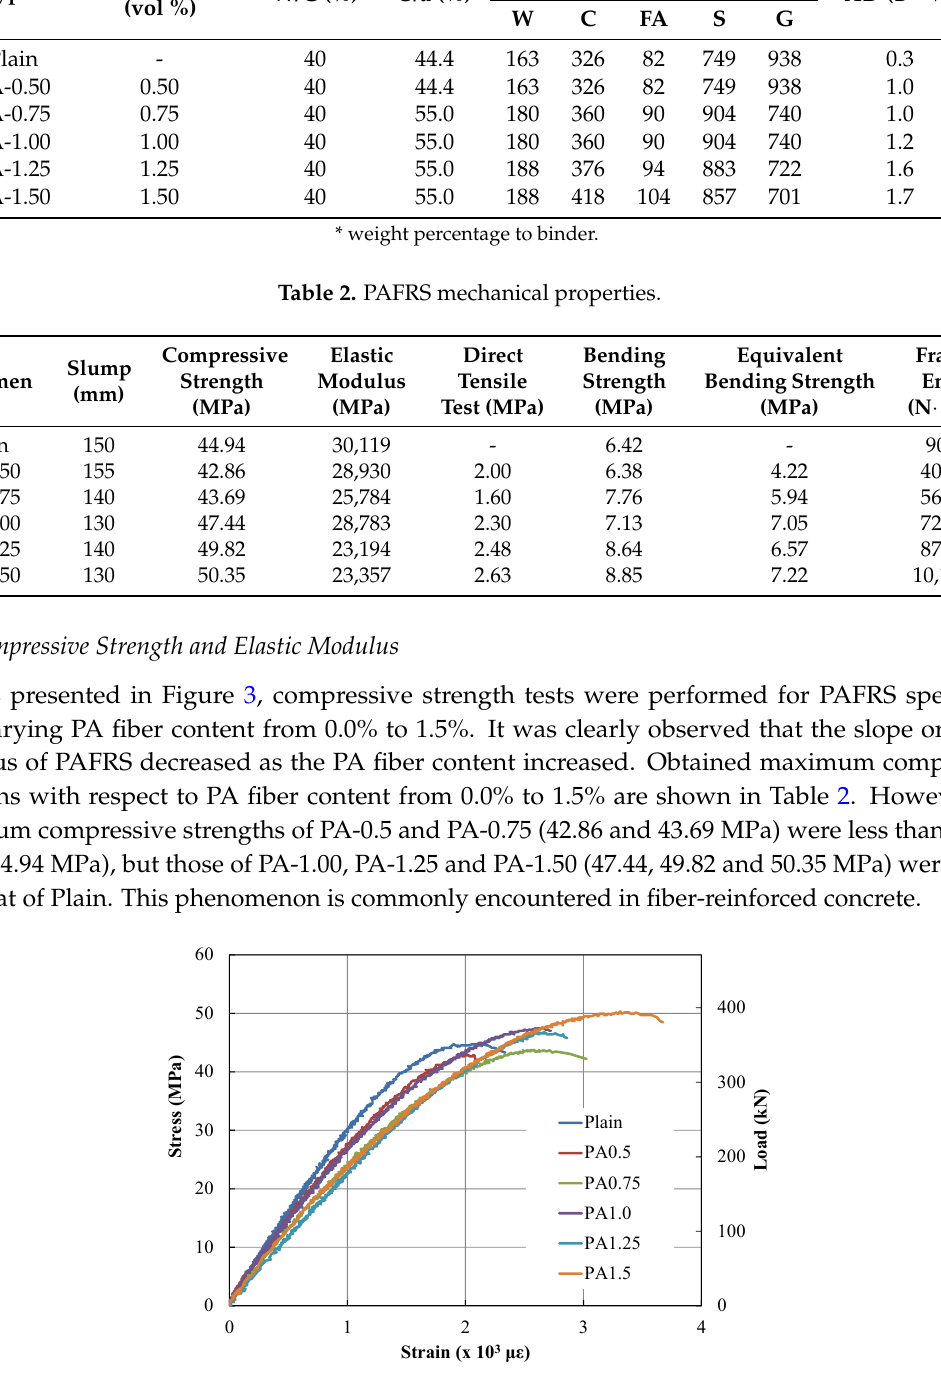
Figure 3. Compressive stress–strain curves of PAFRSs with varying PA contents.